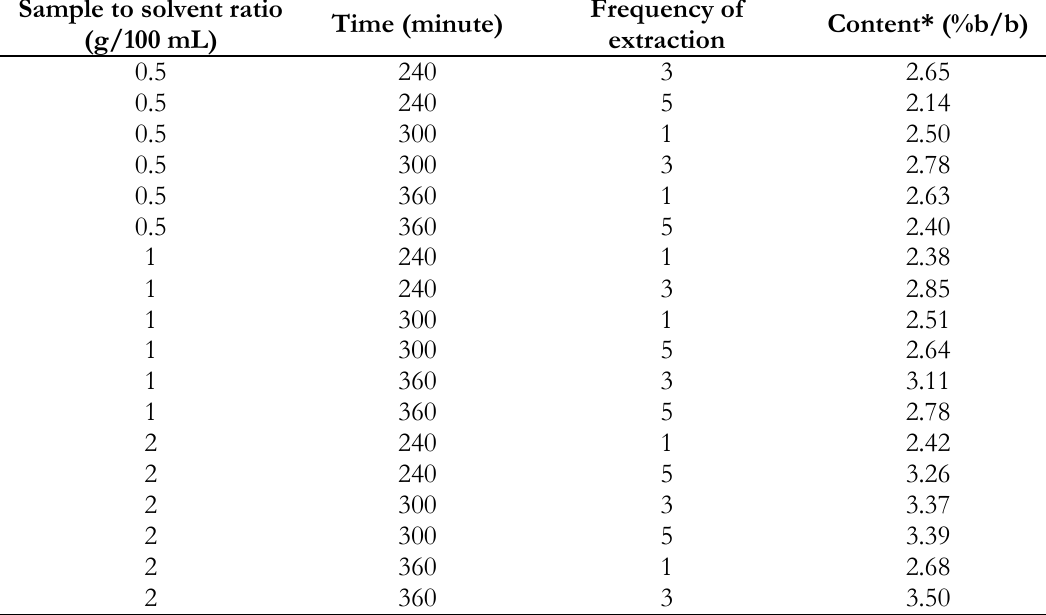
Table III. Prediction on andrographolide content based on experiment which were not